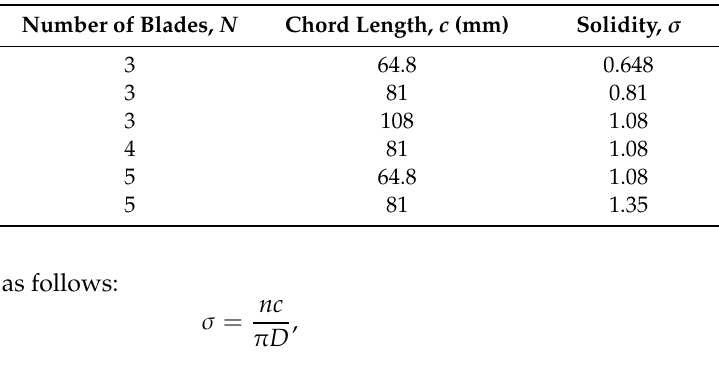
Figure 1. Experimental set-up and VAWT model. Table 1. Description of di ff erent configurations of vertical-axis wind turbines (VAWT)